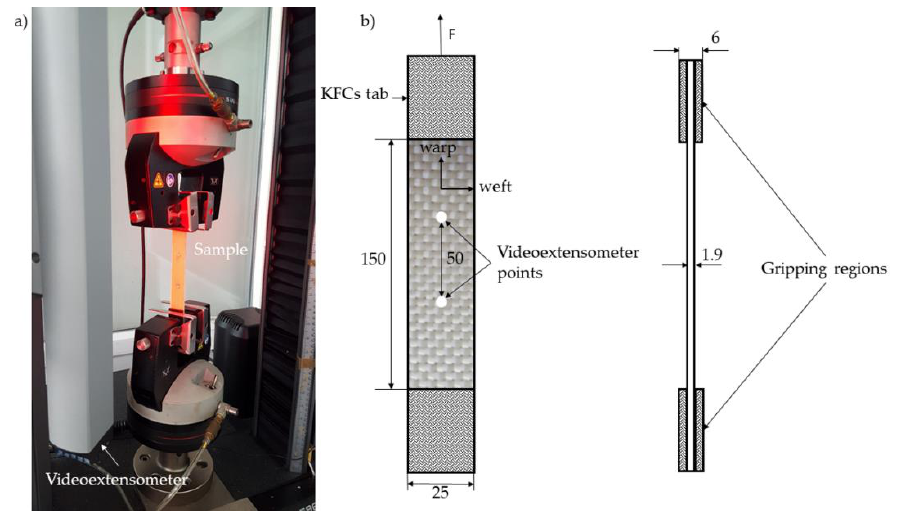
Figure 2. Tensile test setup ( a ) and schematic of tensile specimen geometry (in mm) with sample orientation (warp, weft) and applied force (F) ( b ).